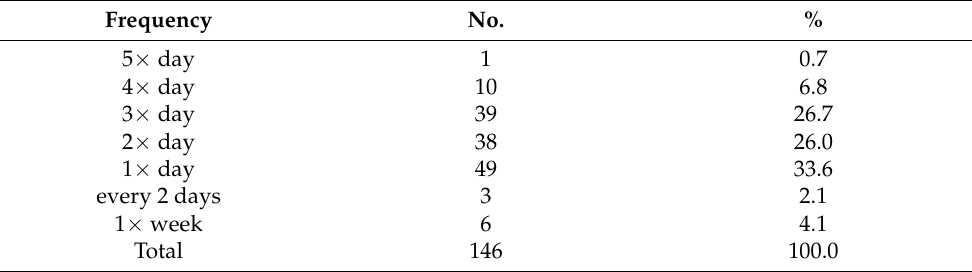
Table 2. Frequency of measuring blood glucose